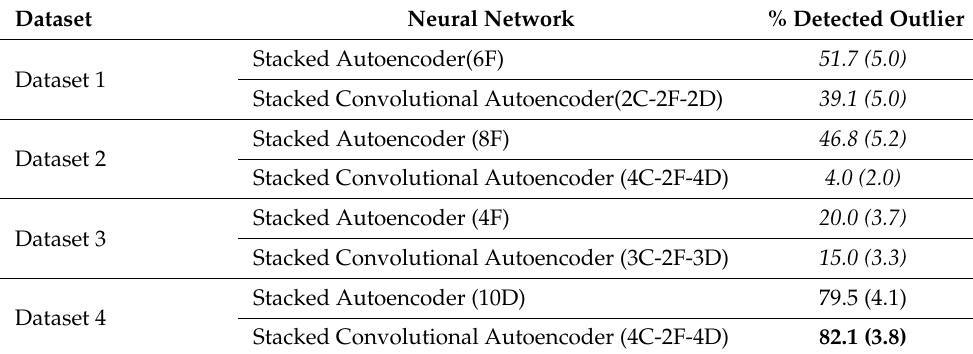
Table 9. Percentage of outliers detected considering the top 100 candidates from 1000 random samples: the mean and standard deviation (in parenthesis) are reported in the last column. The boldface indicates the best